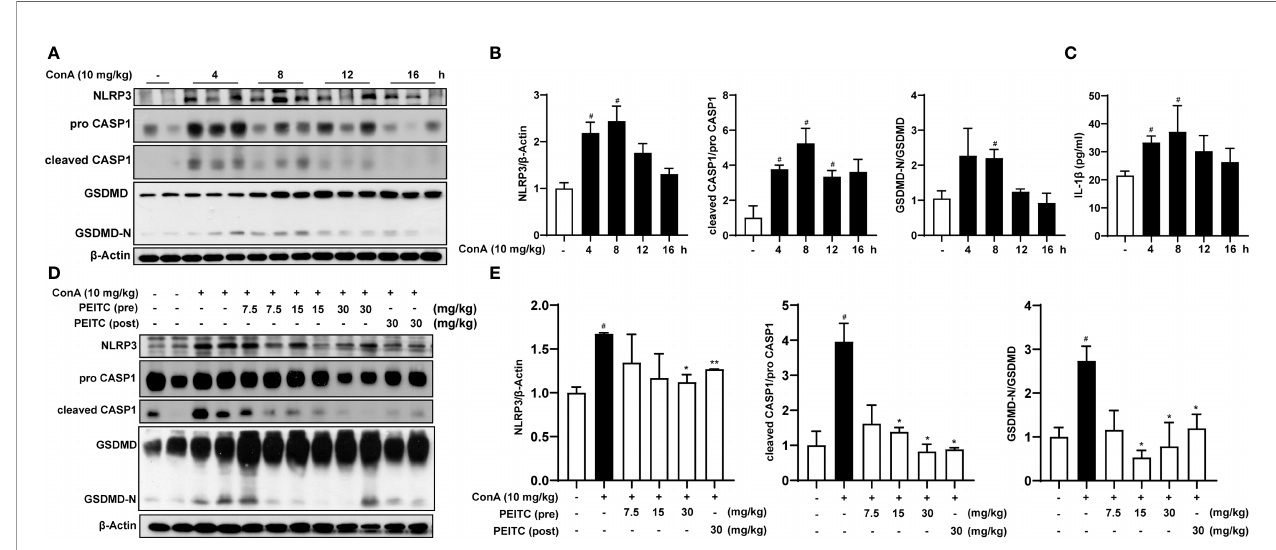
FIGURE 3 | PEITC prevented hepatocyte pyroptosis induced by ConA. (A) Immunoblot analysis of NLRP3, pro-CASP1, cleaved CASP1, GSDMD, GSDMD-N, and b - actin in liver tissues of mice induced by ConA (0, 4, 8, 12, and 16 h). (B) The relative protein levels of NLRP3/ b -actin, cleaved CASP1/pro-CASP1, and GSDMD-N/ GSDMD are displayed as histograms. (C) The expression levels of serum IL-1 b . (D, E) Western blot and statistical analysis of NLRP3, pro-CASP1, cleaved CASP1, GSDMD, GSDMD-N, and b -actin. Data are presented as the means ± SEM ( n = 6 – 10 per group). # p < 0.05 vs. normal group, * p < 0.05, ** p < 0.01 vs. ConA